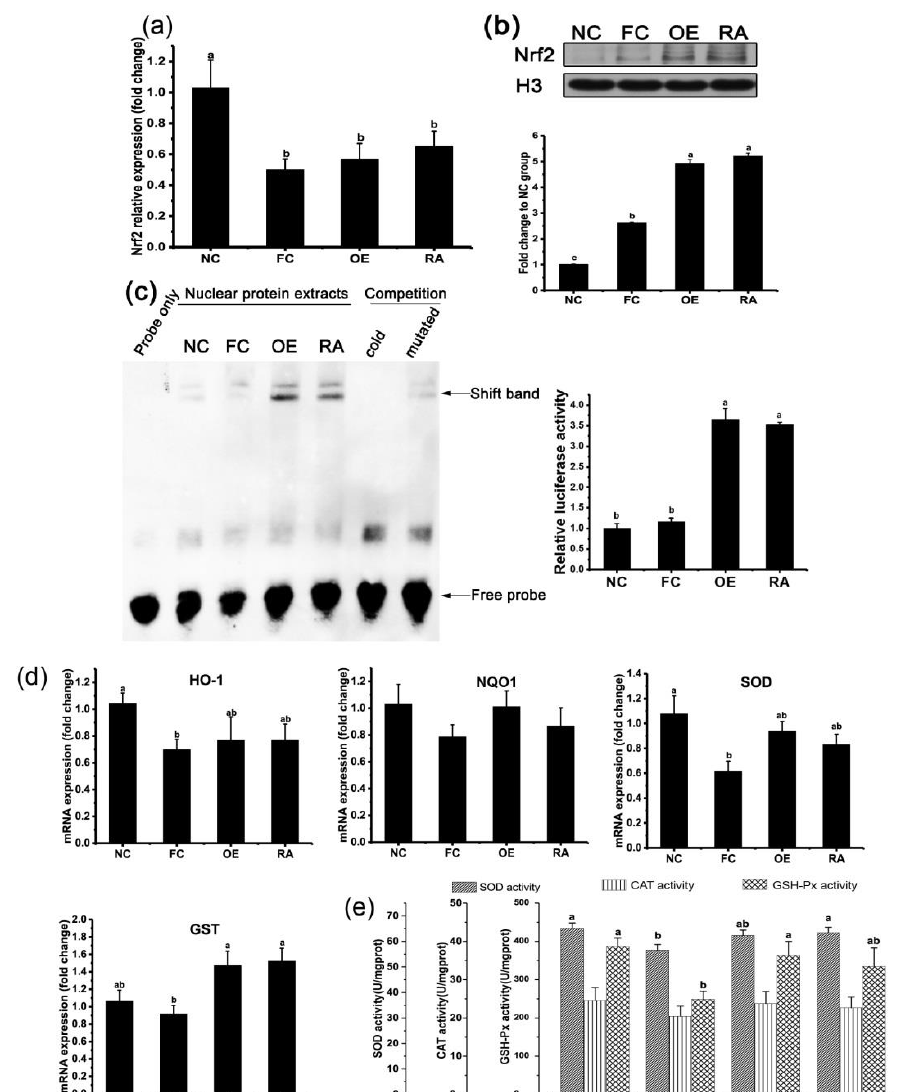
Figure 2. OE and RA activated the nuclear factor E2-related factor 2 (Nrf2) pathway. ( a ) Nrf2 mRNA transcription in the mouse jejunum after different treatments. ( b ) OE and RA trigger nuclear translocation of Nrf2 in the mouse jejunum. ( c ) Nrf2 binding to specific antioxidant-response element (ARE) sites, determined by electrophoretic mobility-shift assay (EMSA). The probe only lane contains a labeled probe with no protein, and nuclear protein extract lanes contain the probe with mouse jejunal epithelial cell nuclear protein extracts. Competition lanes contain 200× unlabeled probe. Gels were read with a scanner, and optical density is expressed as fold change in the NC group. ( d ) Effects of OE and RA on mRNA expression of downstream antioxidant related genes. ( e ) Activity of superoxide dismutase (SOD), catalase (CAT), and glutathione peroxidase (GSH-Px) in the mouse jejunum. The bar represents the SEM, with different letters being statistically significantly different in all figures ( P < 0.05).